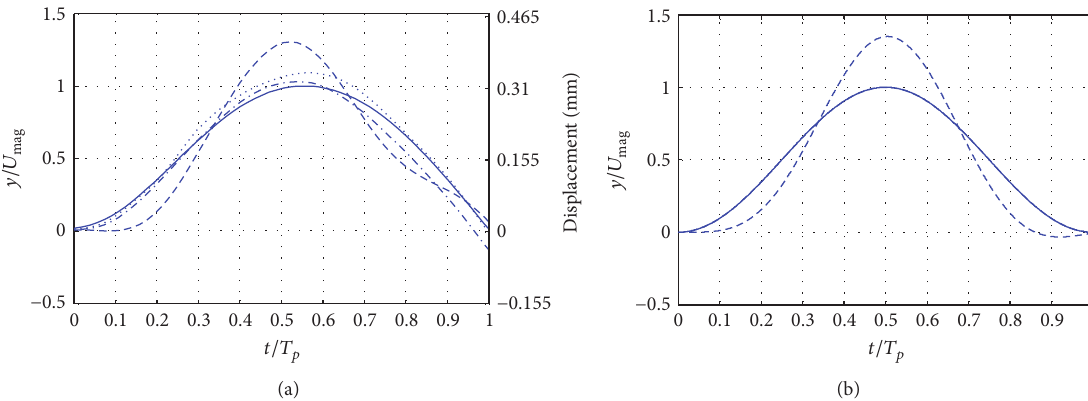
Figure 23: Displacement response of the thin secondary beam system with high friction. (a) Measured. Solid line: base input. Dashed line: response at the end of the primary beam (sensor 2). Dash-dotted line: response at the end of the secondary beam (sensor 3). Dotted line: response at the end of the secondary beam (sensor 4). (b) Simulation with high Coulomb friction. Solid line: base input and response of the secondary mass. Dashed line: response of the primary